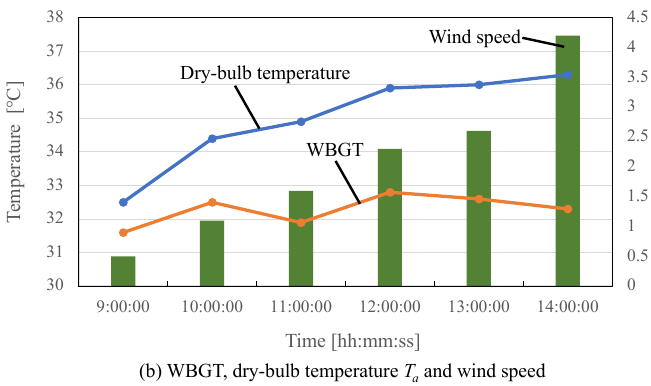
Figure 7. Variation of heart rate, pHST, environmental temperatures, and wind speed